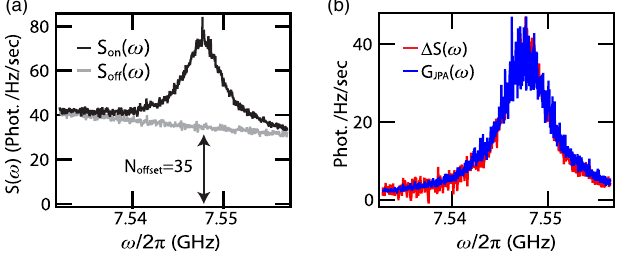
FIG. 6. (a) Measured power spectra S ( S ) taken with the on off JPA on (off). The peak in the power spectrum acquired with the JPA turned on corresponds to amplified vacuum noise. The noise offset N is referenced to the input of the JPA. (b) JPA gain offset ω Þ overlapped with the difference between the two power G JPA ð ω Þ − S ω Þ spectra, Δ S ð ω Þ ¼ S on ð off ð